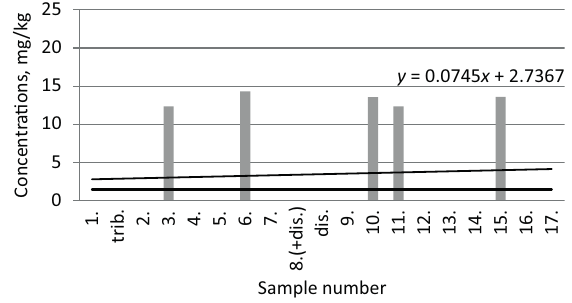
Fig 12. Cd concentrations on the left bank, downstream trend ( y ), the concentration of the I sludge category (bold